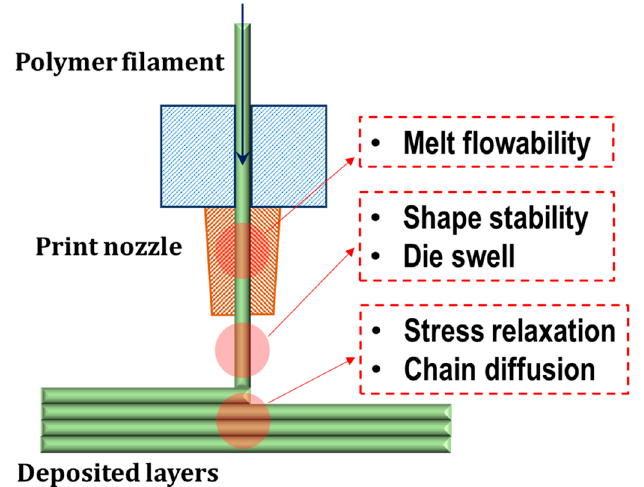
Figure 1. Schematic of FDM process and rheological characteristics of melt filament affecting the different processing stages.